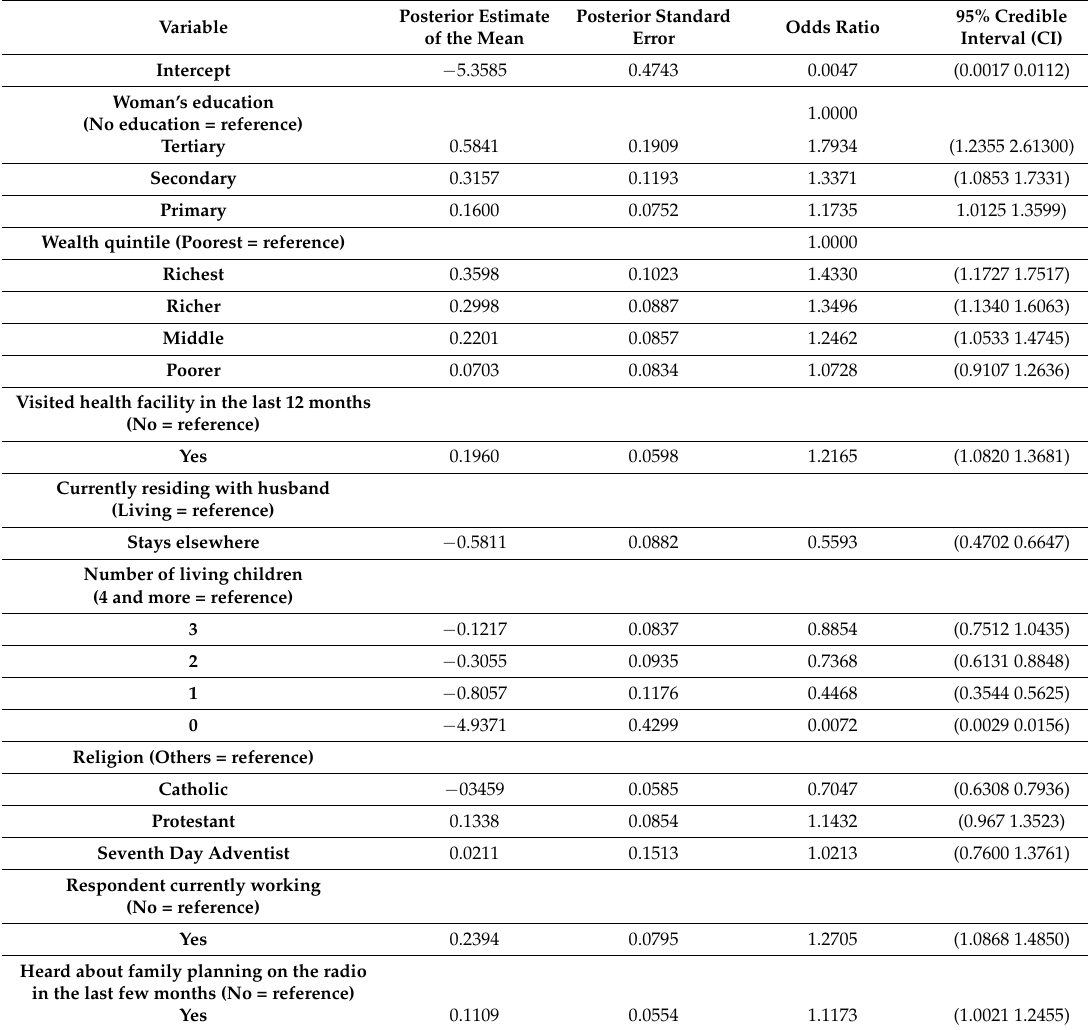
Table 5. Summary of fixed effects of factors associated with women of childbearing age. Variable